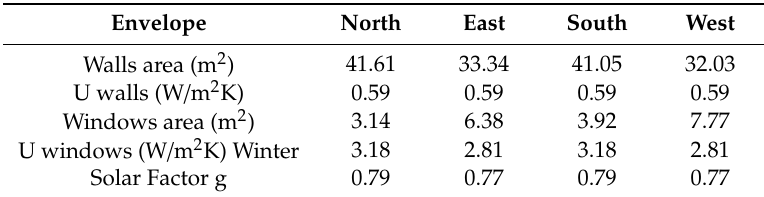
Table 2. Building Parameters: Vertical elements.